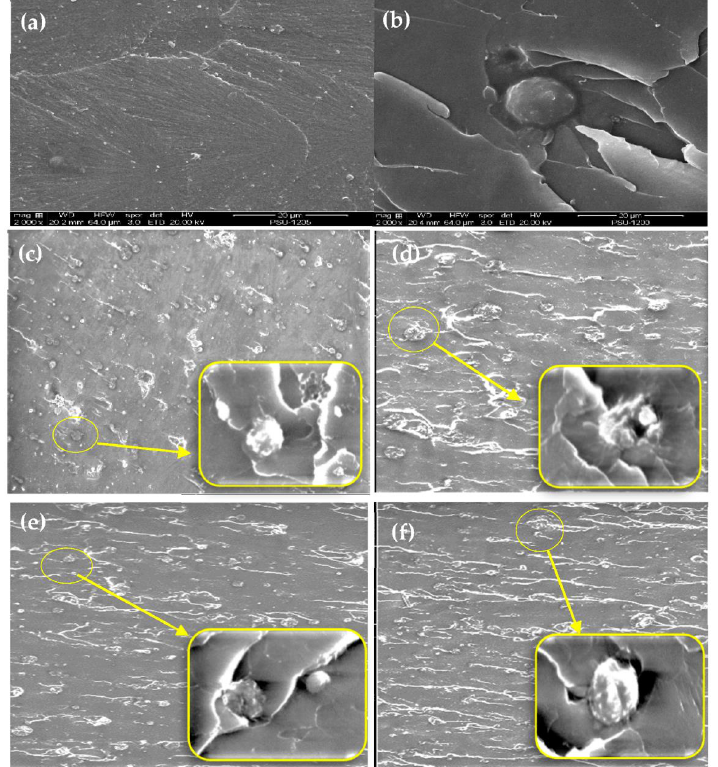
Figure 5. SEM micrographs of; ( a ) epoxy resin, ( b ) epoxy resin/5 phr ENR 50, and nanocomposite with nanosilica, amounts 1 – 4 phr ( c – f